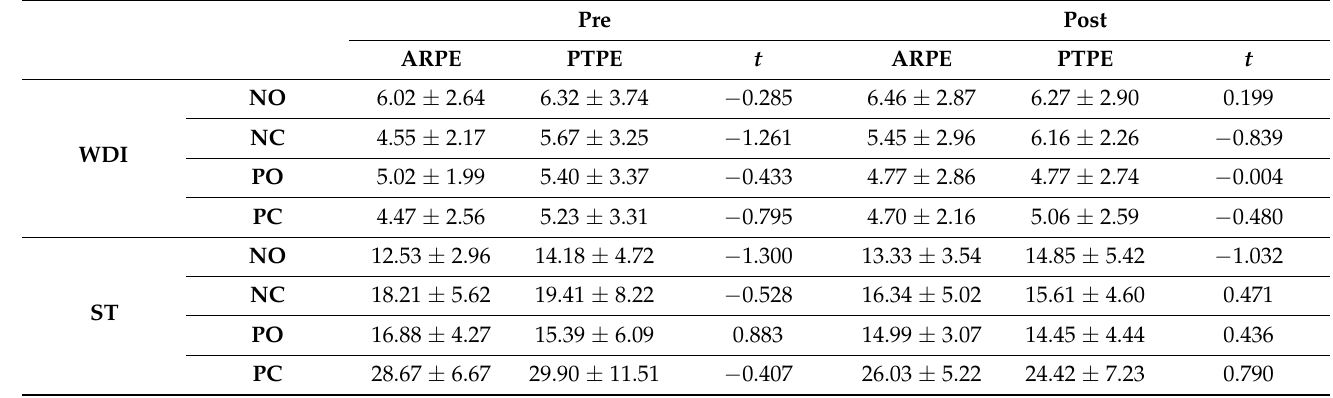
Table 4. Comparison of static balance between groups after